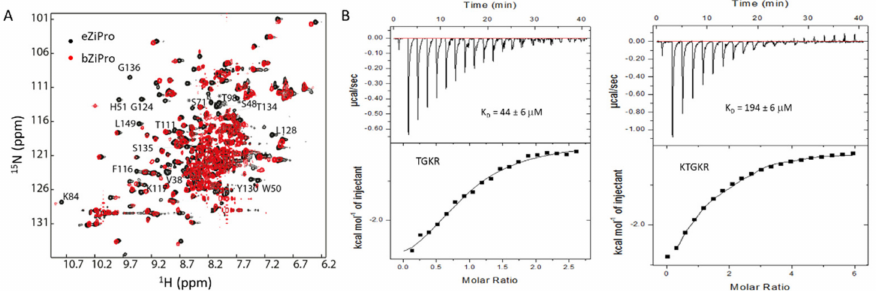
Figure 4. Dynamics and conformational changes in ZIKV protease. ( A ). Overlay of 1 H- 15 N-HSQC spectra of eZiPro and bZiPro. This figure is obtained from the reference [58]. The 1 H- 15 N-HSQC spectra of eZiPro and bZiPro are shown in black and red, respectively. More cross-peaks appeared in eZiPro suggests that substrate binding to protease suppresses exchanges. ( B ). Binding affinity between protease and peptides. The weak binding affinity is important for the function of the protease. This figure was obtained from the reference [108] with